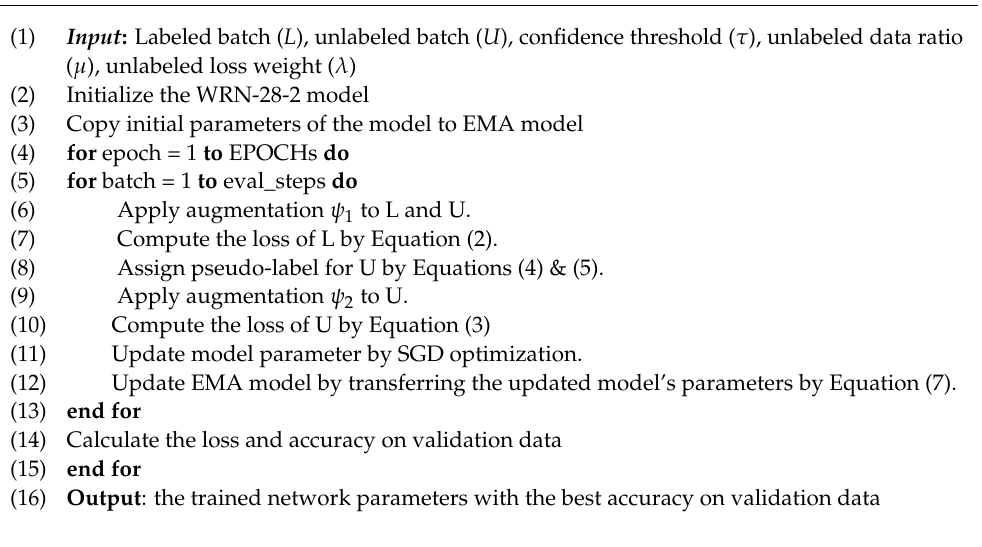
Algorithm 1 Pseudocode of PCB_SS